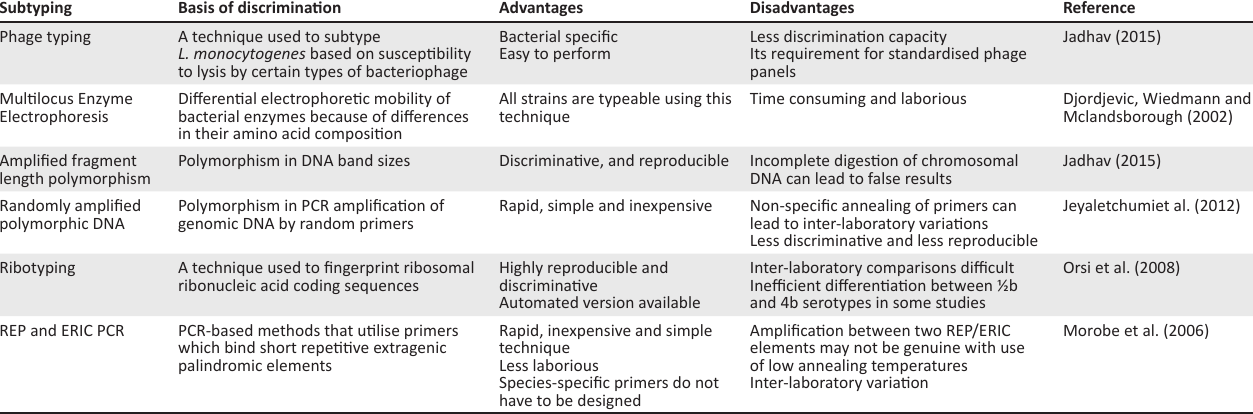
TABLE 4: Advantages and disadvantages of subtyping techniques used for Listeria monocytogenes strains.